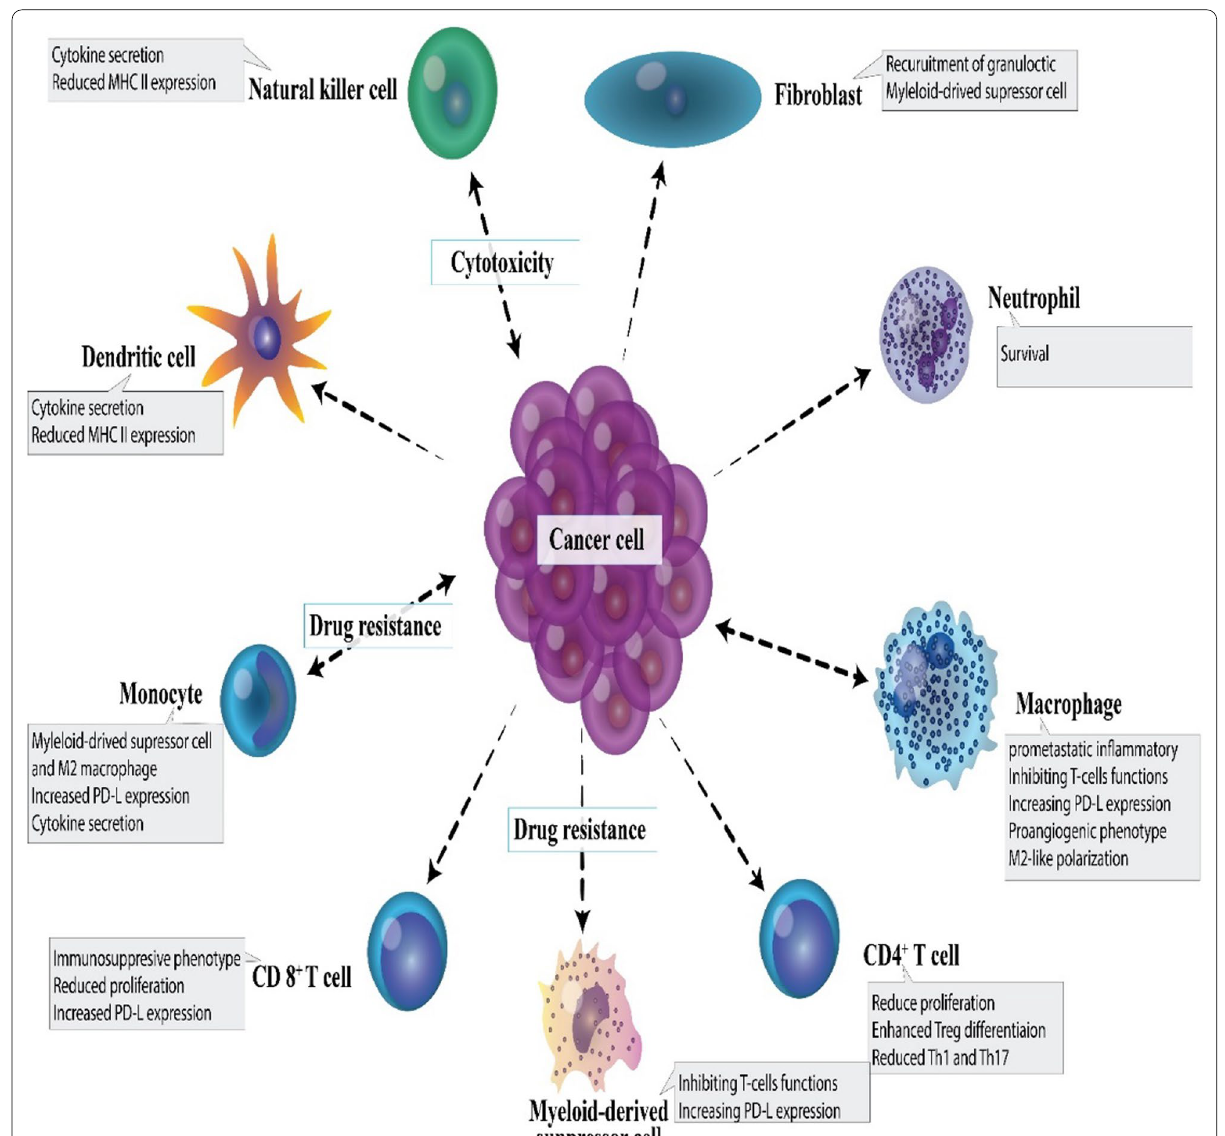
Fig. 2 The immune polarization during cancer. The tumor milieu can participate in the immunosuppression and diminished anti-tumoral functions of different immune cells and cause the immunoinhibitory phenotype of immune cells. For example, Th cell lineages, including Th1, Th2, and Th17, during cancer have been polarized to Th2 and regulatory T cells (Tregs); consequently, CTL-mediated cancer cell cytotoxicity can be hampered via recruitment and/or conversion of Tregs and myeloid-derived suppressor cells (MDSCs) (Hu et al.